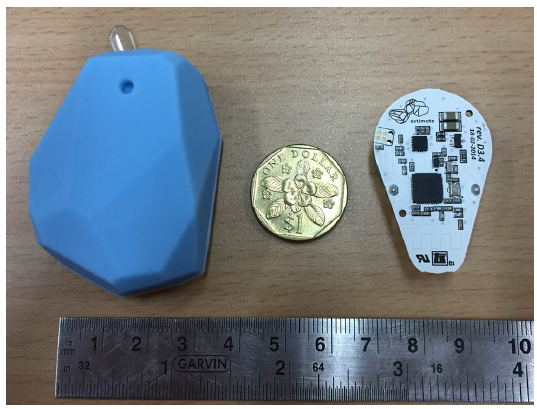
Figure 7. Estimote BLE